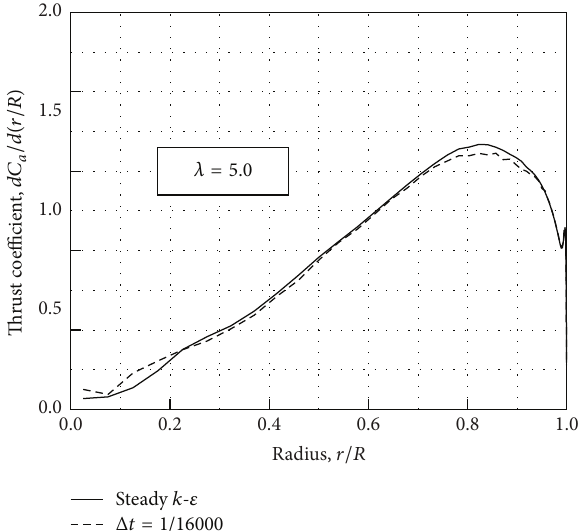
Figure 11: Local axial velocity at rotor for tip speed ratio 𝜆 = 5 .